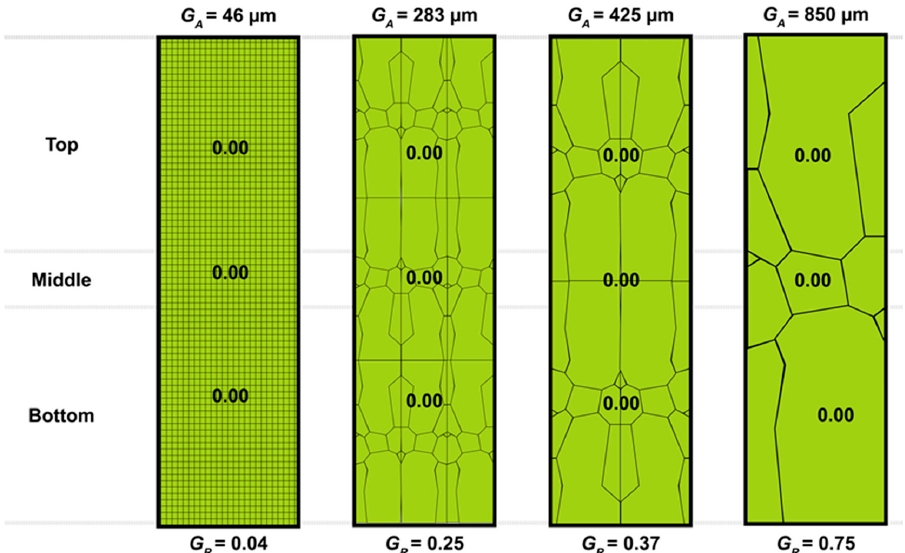
Figure 13. The grain boundaries of the four considered cases (small to large grain sizes) having the same grain orientation.